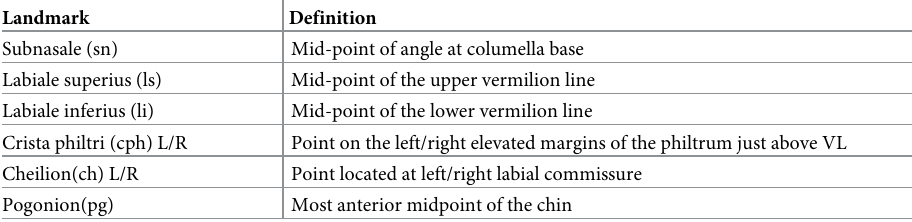
Table 1. Biological definitions of soft tissue landmarks in the lip